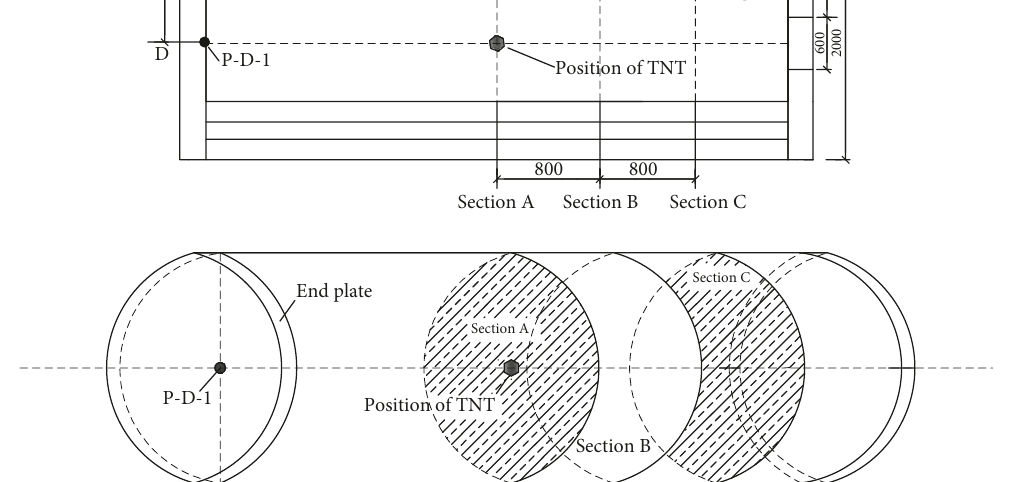
Figure 5: Position of pressure sensors.